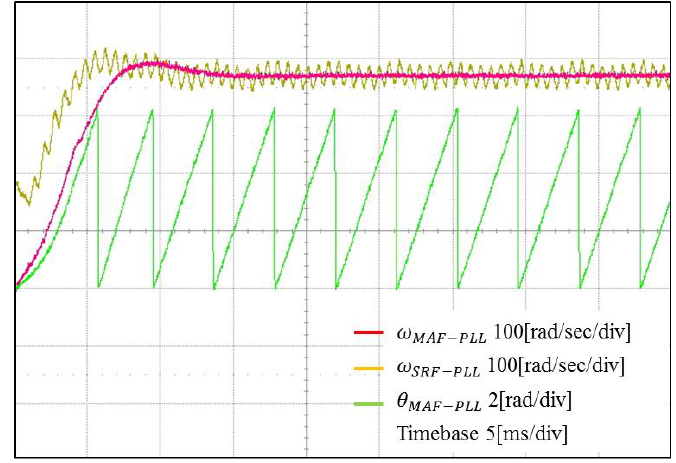
Figure 20. Experimental results for the SRF-PLL and MAF-PLL under the distorted grid voltages.